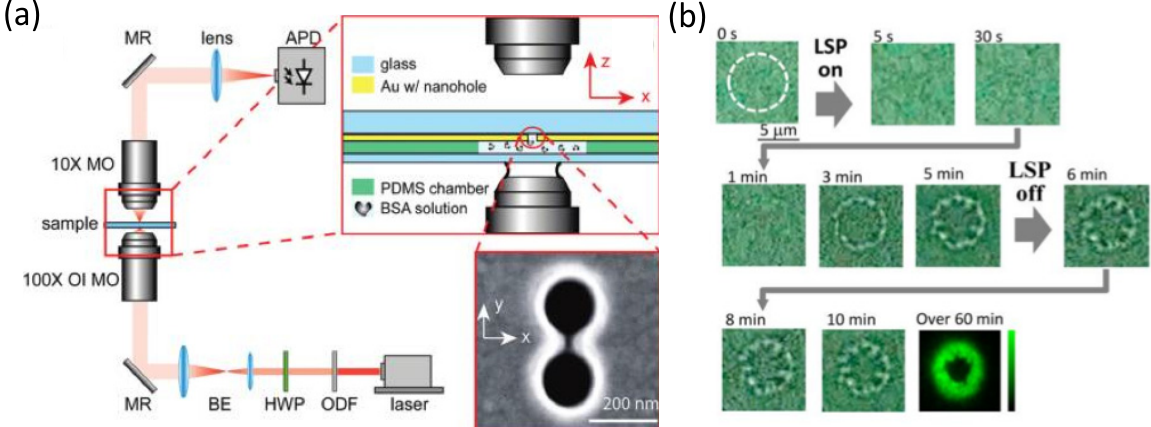
Figure 2. Molecular manipulation with plasmonic optical tweezers. ( a ) Schematic of experimental setup for trapping of a single bovine serum albumin (BSA) protein. The single BSA protein is trapped in the gap of a double-hole nanostructure. The nanostructure is shown in the inset scanning electron microscope (SEM) image. Reproduced with permission from [33]. Copyright 2012, American Society of Chemistry. ( b ) Micro-pattern of DNA on a substrate patterned with a gold nanostructure. Reproduced with permission from [37]. Copyright 2013, American Society of